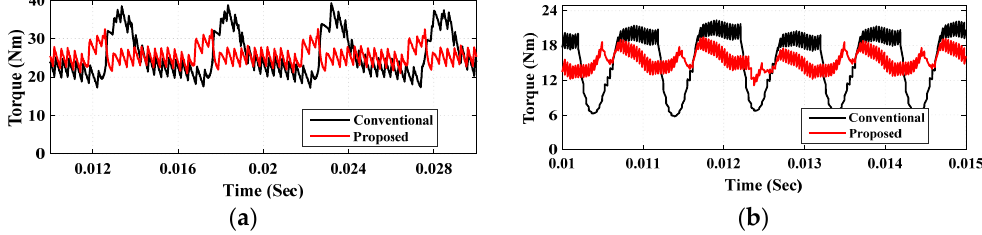
Figure 9. The steady-state torque curves at: ( a ) low speed (500 r/min); ( b ) high speed (2500 r/min).